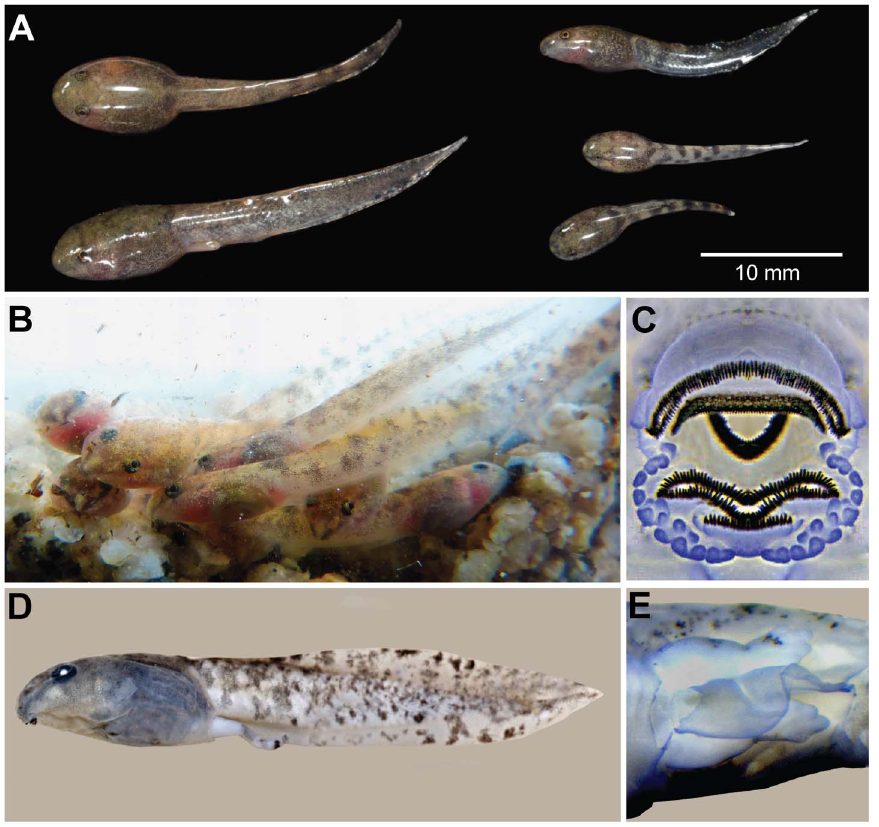
Fig. 3. Free swimming Limnonectes larvaepartus tadpoles. (A) Tadpoles from Kaluku, West Sulawesi (JAM 14268; stages 25, 29 and 34–36) collected from a small pool at the margin of a stream, (B) tadpoles ejected from MZB Amp 23978 at stages 26–27, (C) oral disc of MZB Amp 23982a at stage 31, (D) lateral view of MZB Amp 23980a at stage 36, and (E) the vent tube of MZB Amp 23980b at stage